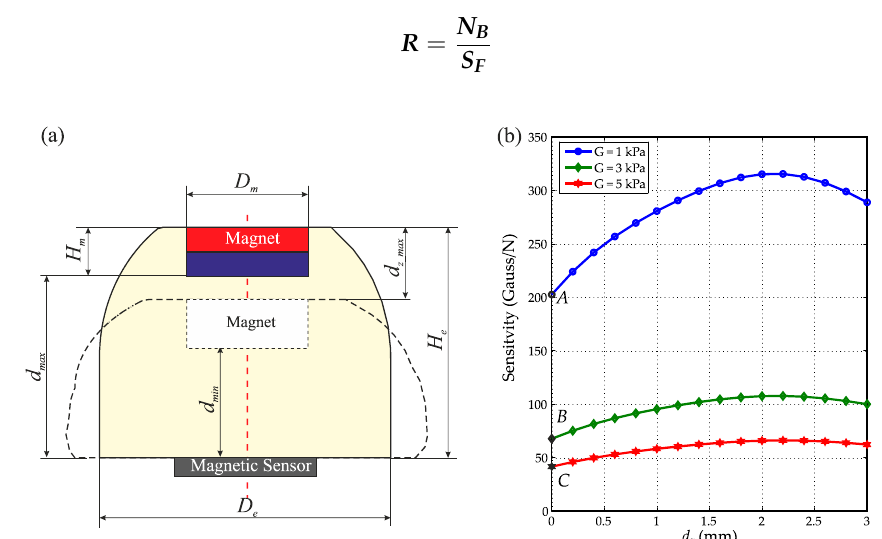
Figure 7. ( a ) The design parameters of the tactile sensor; ( b ) The sensitivity of the tactile sensor with different material properties (shear modulus G = 1, 3, 5 kPa). Points A–C indicate the point of lowest sensitivity for each material.